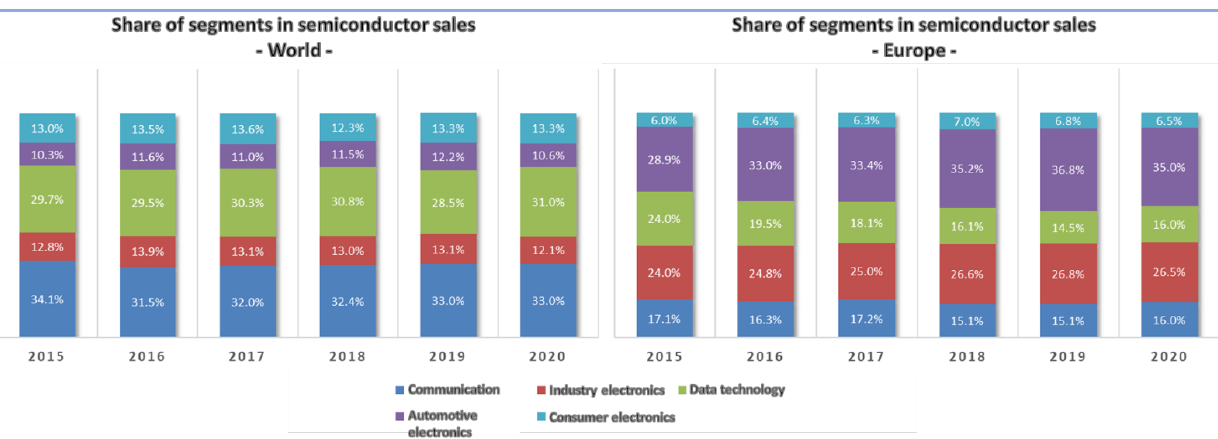
Figure 1. Development of market shares in semiconductor sales, 2000–2020 [3,4].